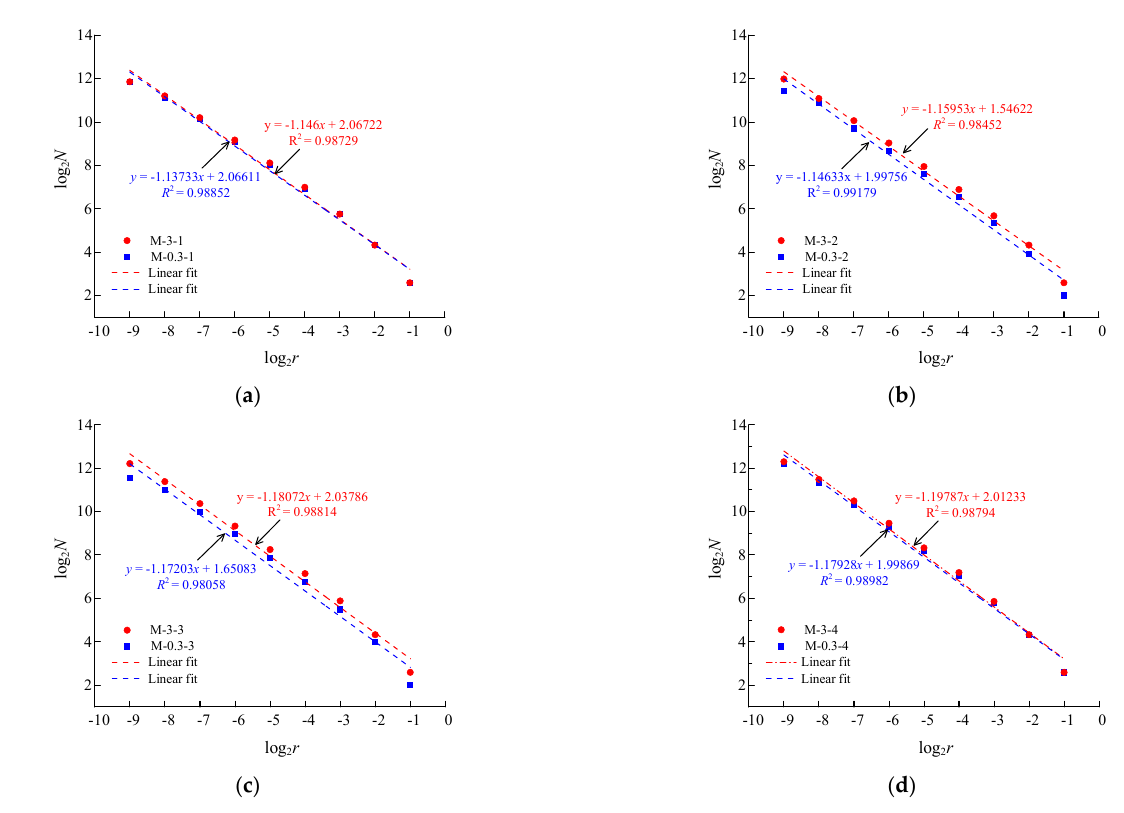
Figure 10. The relationship between log 2 N and log 2 r of coal specimens under different numbers of prefabricated cracks. ( a ) Prefabricated crack number of 1; ( b ) prefabricated crack number of 2; ( c ) prefabricated crack number of 3; ( d ) prefabricated crack number of 4.